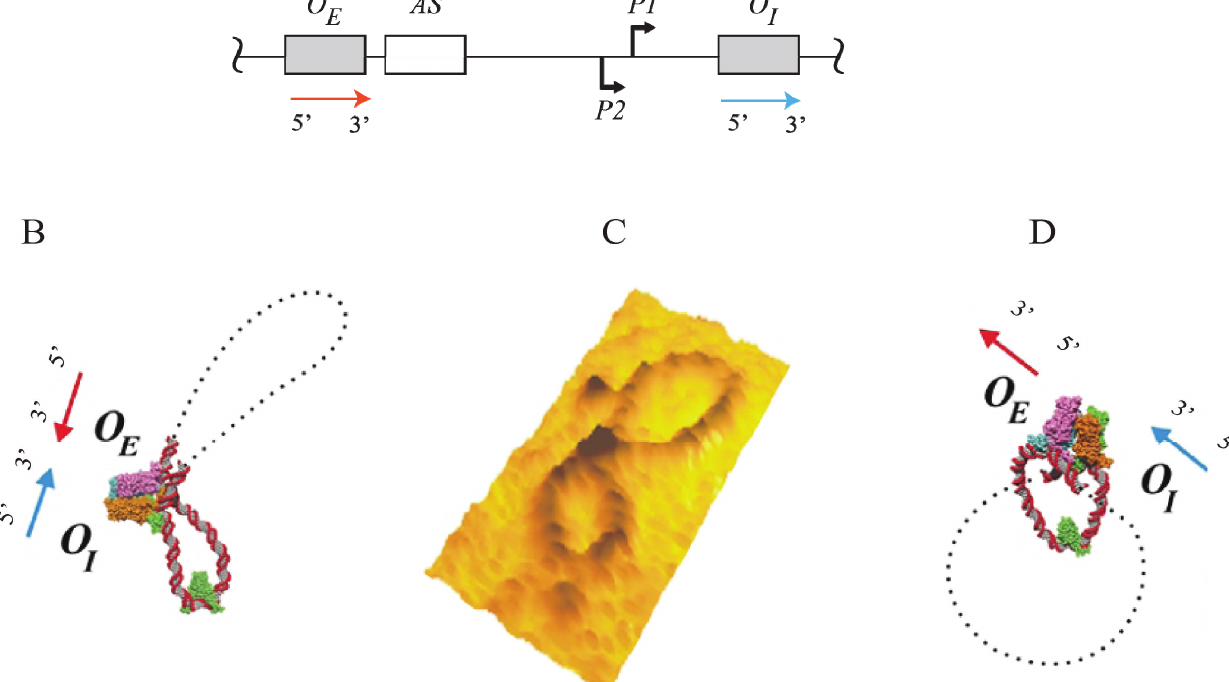
Figure 11. Atomic force microscopy of GalR-HU mediated DNA loops. ( A ) Sketch of the gal DNA with a red arrow in the direction of 5' to 3' for O E and with a blue arrow in the direction of 5' to 3' for O I ; ( B ) Model of antiparallel loop with the 3' of O E and O I facing each other in a head-to-head arrangement; ( C ) AFM results showing an antiparallel loop as predicted in model (B); ( D ) Model of parallel loop with the 3' of O E and O I facing opposite direction in a tail-to-head arrangement (reproduced with permission from Elsevier